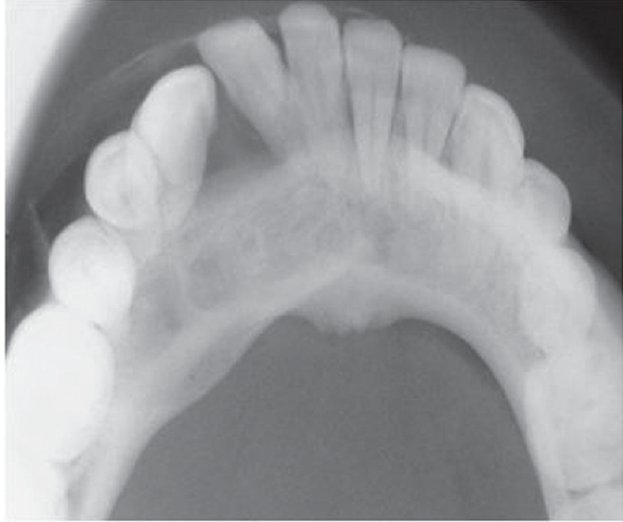
Fig. 6. Orthopantomogram showing multilocular lesion with root resorption of left mandibular premolars and canine.